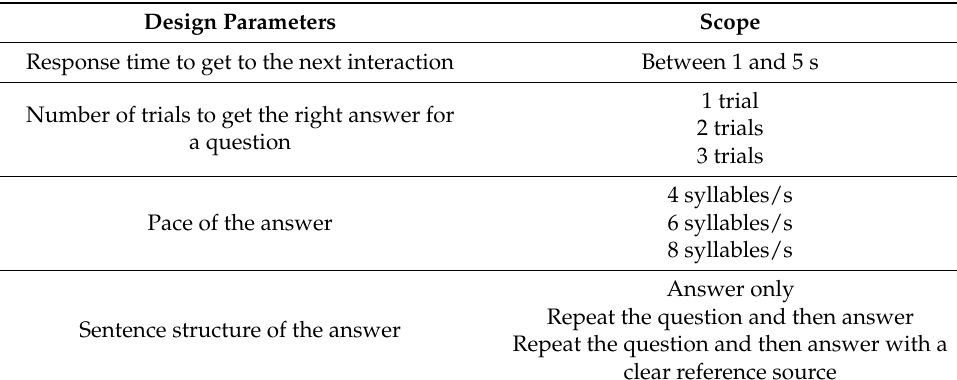
Table 1. Scope of voice-based intelligent system design parameters. Design